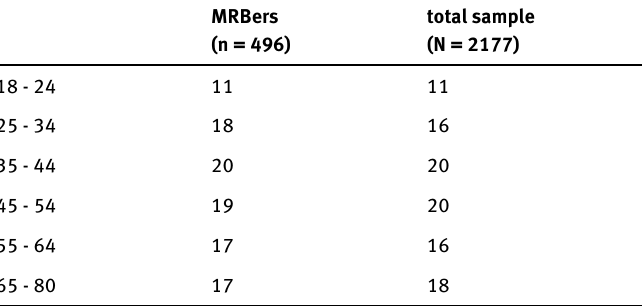
Table 12. Age distribution of MRBers (%)